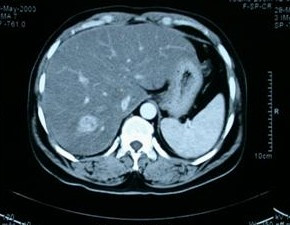
CT scan image showing the hepatic metastasis in segment VII.